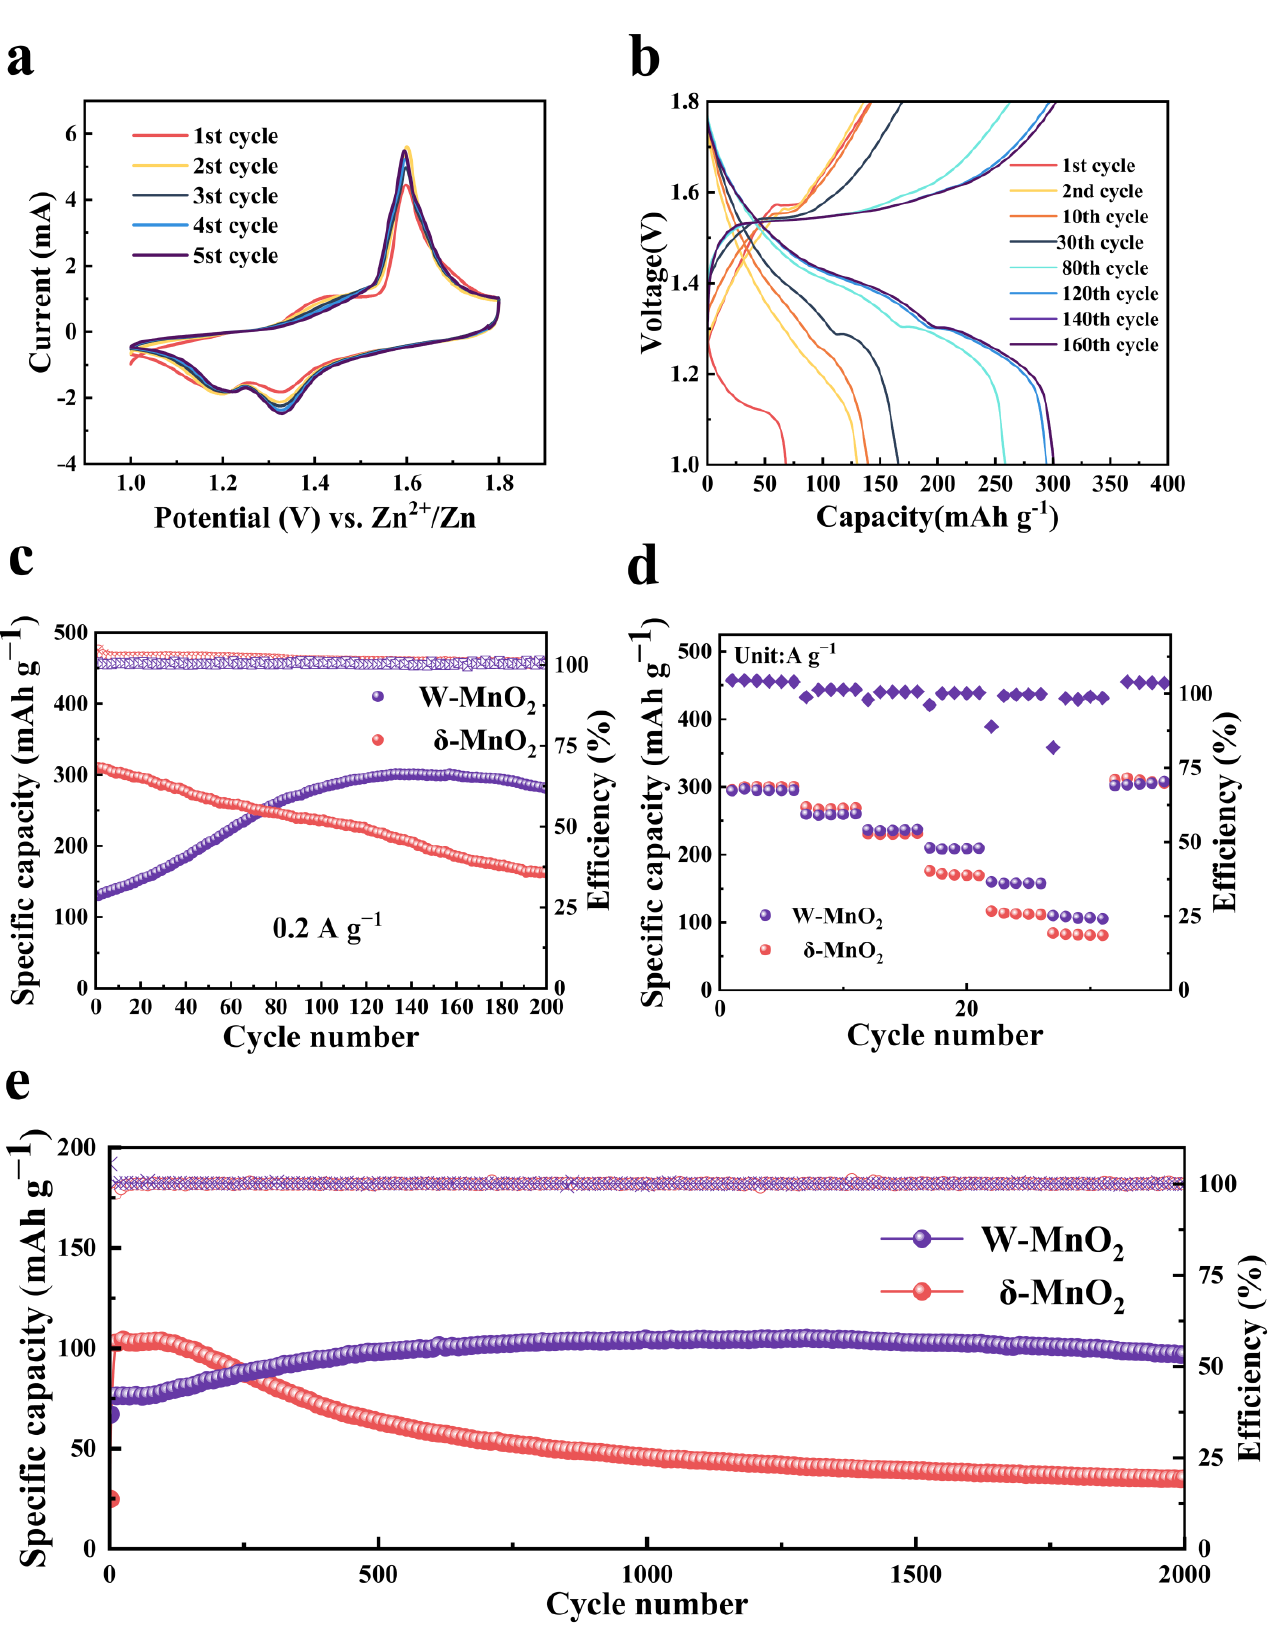
Figure 2. Electrochemical performance of δ-MnO 2 and W-MnO 2 cathodes. ( a ) CV curves of W-MnO 2 cathode at 1 mV s −1 . ( b , c ) Galvanostatic charge and discharge curves of the W-MnO 2 cathode and corresponding cycling performance at 0.2 A g −1 . ( d ) Rate capacity of δ-MnO 2 and W-MnO 2 cathodes with current density from 0.2 to 10 A g −1 . ( e ) Cycling performance at 10 A g −1 .